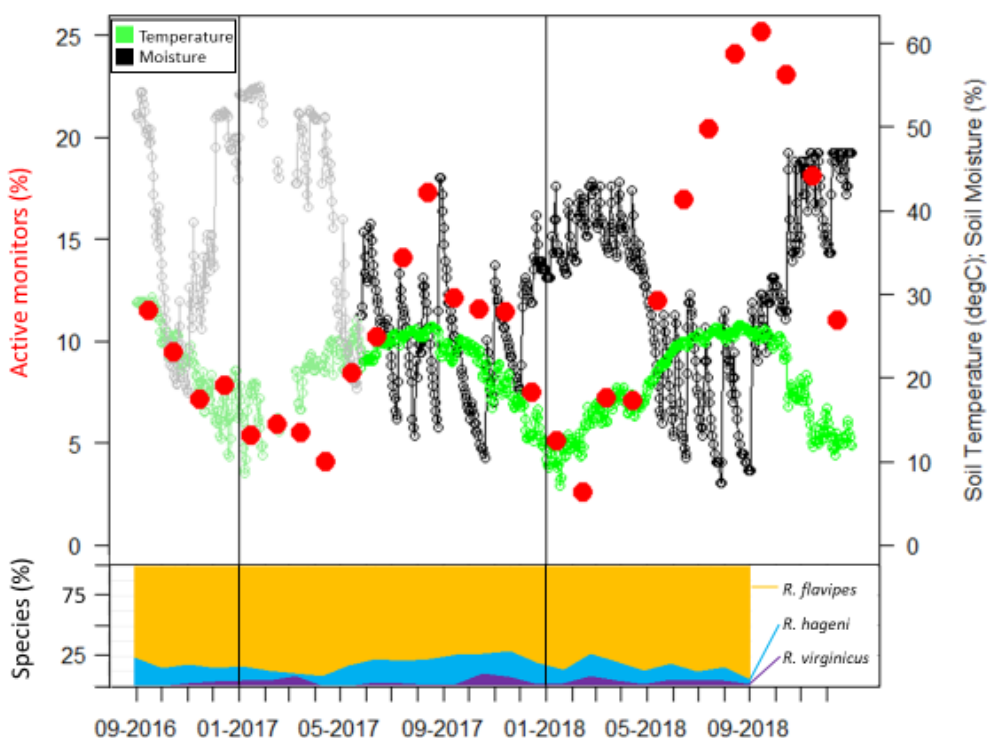
Figure 2. Active monitors, soil temperature, and soil moisture over 28 months. Species identifications were only determined for the first 24 months and percentages of each species are presented as a stacked line graph (bottom portion). The gray and light green portion of graph are data obtained from the USDA Natural Resources Conservation Service Soil Climate Analysis Network data for Beaumont, TX, USA.